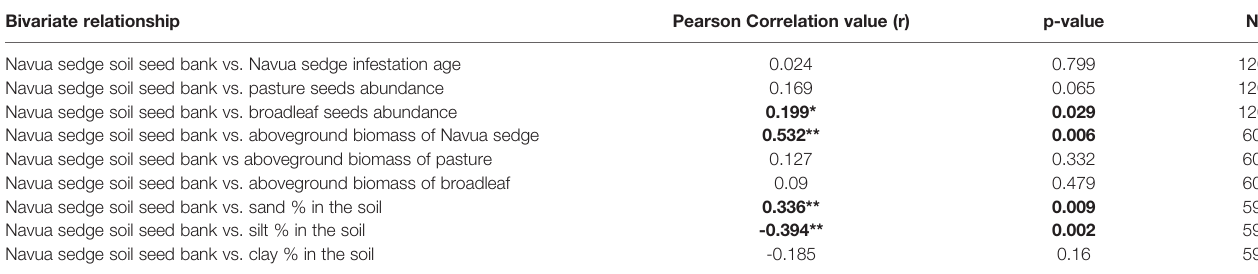
TABLE 3 | Pearson ’ s correlation coef fi cients (r) for correlation of the amount of Navua sedge seeds present in the soil. Bivariate relationship Pearson Correlation value